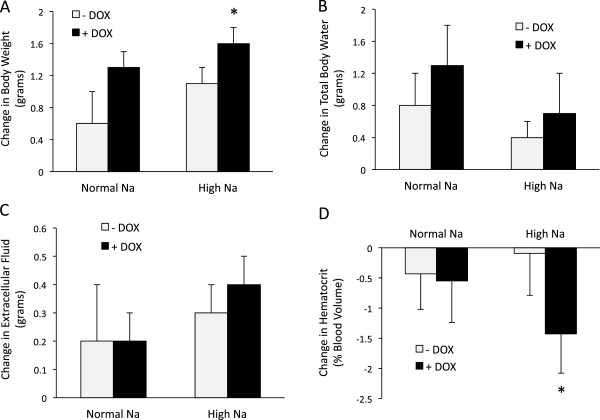
Change in body volume status in Pax8-rtTA/LC1/floxed ETA (iETA) mice comparing before and after vehicle or doxycycline (DOX) treatment. Animals were fed a normal (0.3%) Na diet for 7 days followed by a high (3.2%) Na diet for 7 days, then treated with DOX, and the diets repeated; measurements were obtained on the 7th day of each diet. Panel A shows change in body weight, Panels B and C show changes in total body water and extracellular fluid volume, respectively, as assessed by impedance plethysmography, and Panel D shows the change in hematocrit. N = 8 each data point. *p < 0.05 vs. –DOX, same diet.